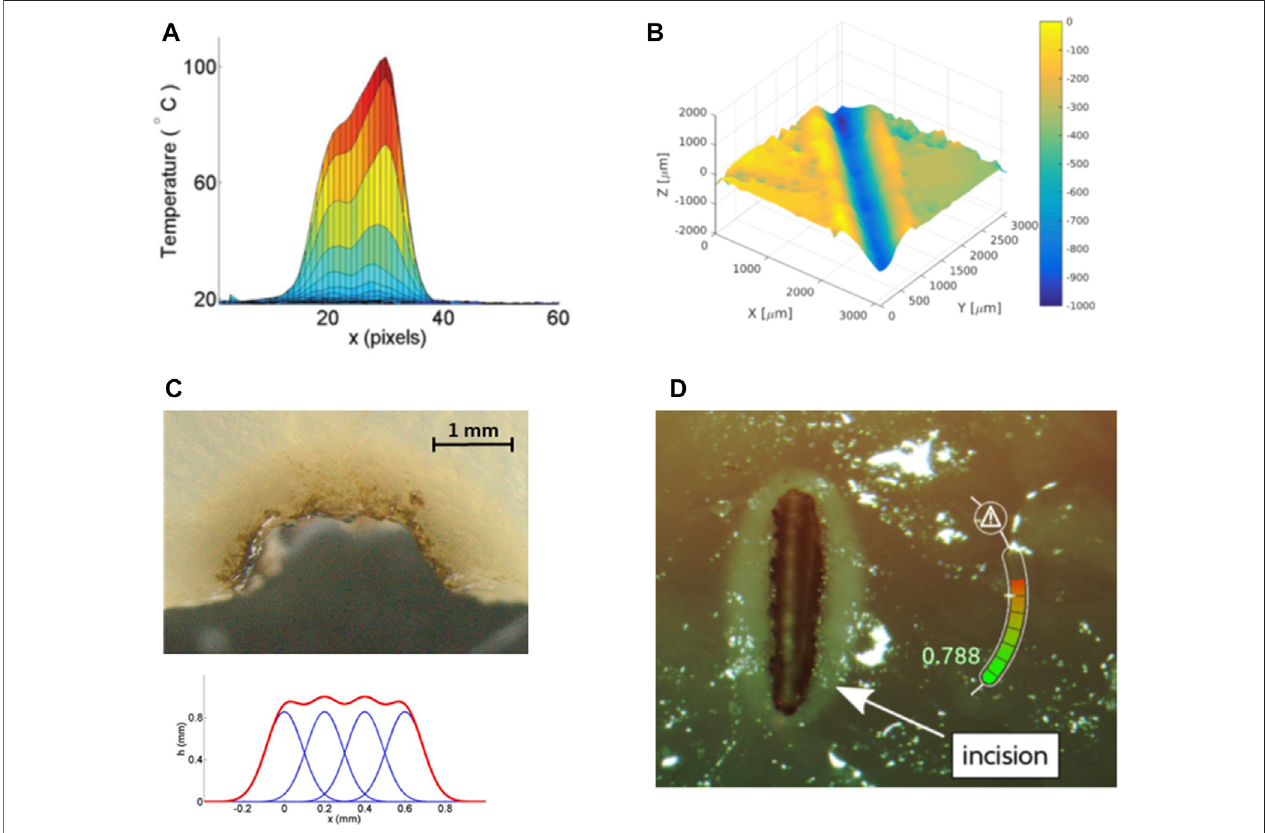
FIGURE 13 | Results from research on cognitive modeling and control of laser-tissue interactions. (A) Real-time estimate of super fi cial tissue temperature during high-powerlaserscanning(Pardoet al.,2014). (B) Autonomouslaserincision depthcontrolalongincision paths(Acemoglu etal.,2019). (C) Autonomoustissuevolume vaporization by laser ablation (Fichera et al., 2015b). (D) Augmented reality gauge for displaying the laser incision depth progression in real-time (Fichera et al., 2016).